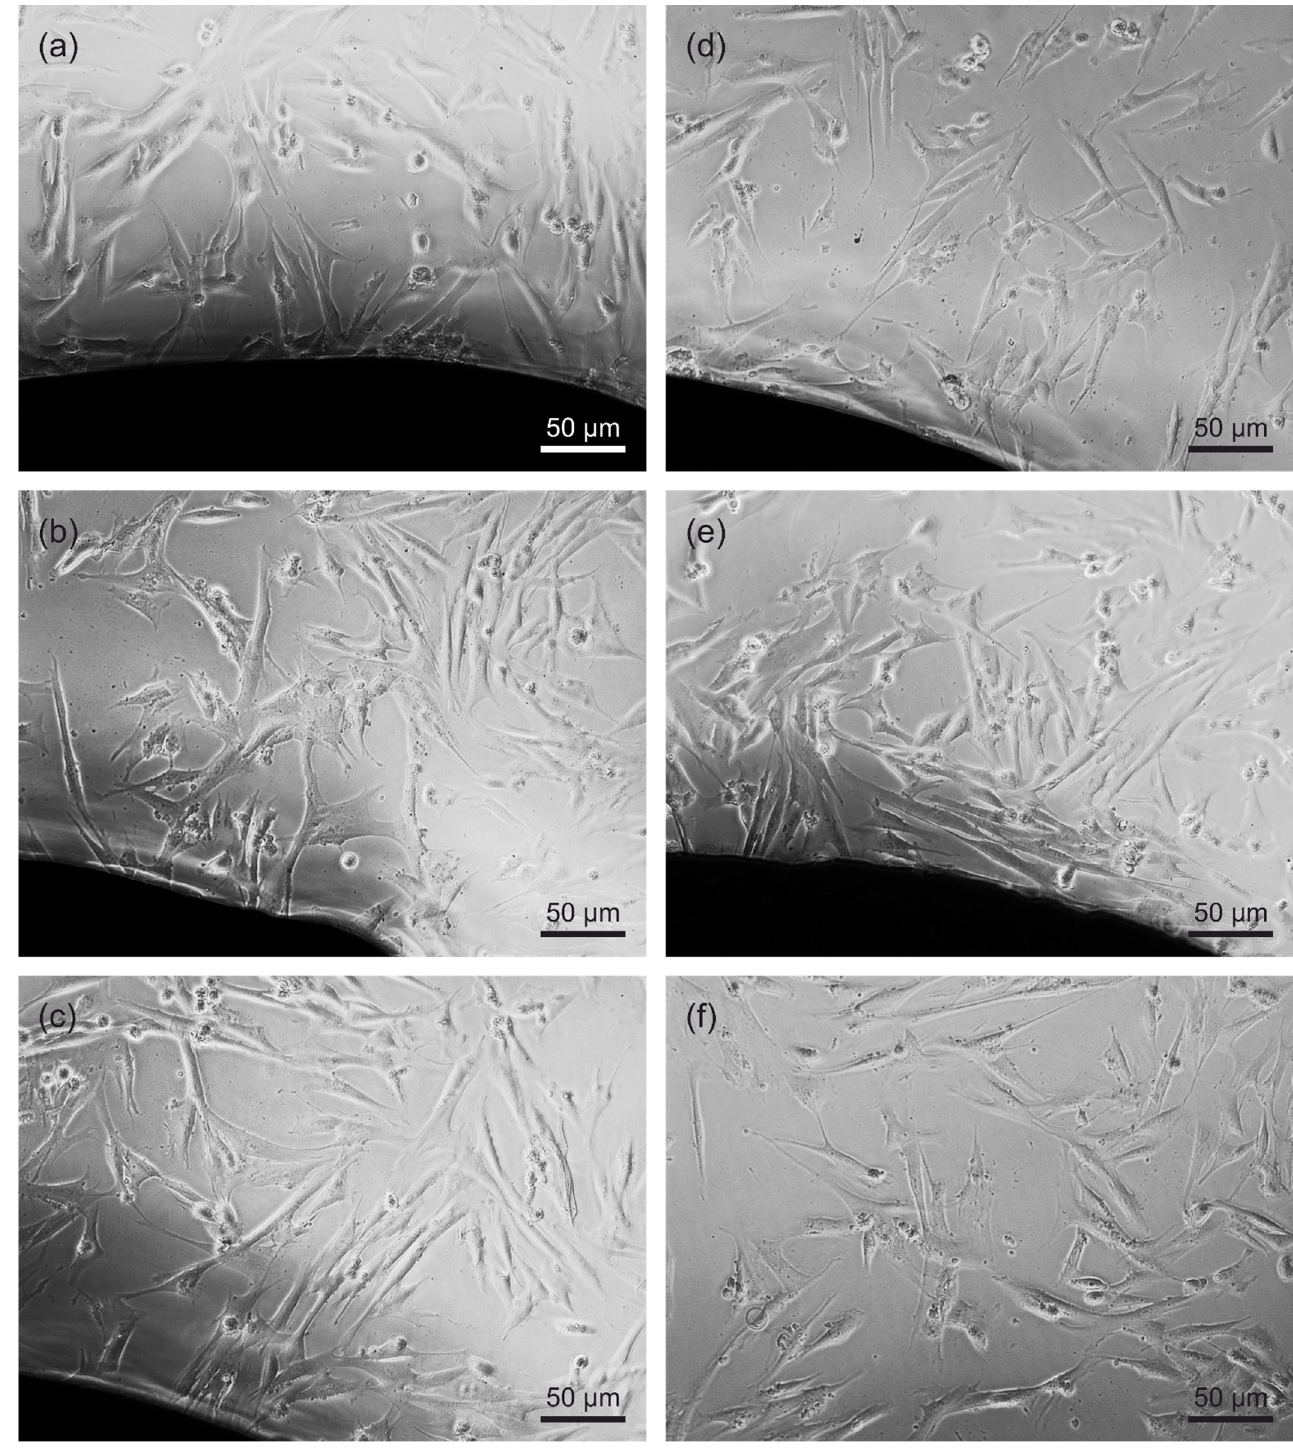
Figure 6. Phase contrast micrographs of fibroblasts (IMR90 cell line) cultured for 24 h on ( a ) Zr 40 Ti 15 Cu 10 Ni 10 Be 25 , ( b ) Zr 50 Ti 5 Cu 10 Ni 10 Be 25 , ( c ) Zr 40 Ti 15 Cu 10 Ni 5 Si 5 Be 25 , ( d ) 316L steel, and ( e ) Ti6Al4V alloy. ( f ) Fibroblasts cultured on glass slides served as a negative control